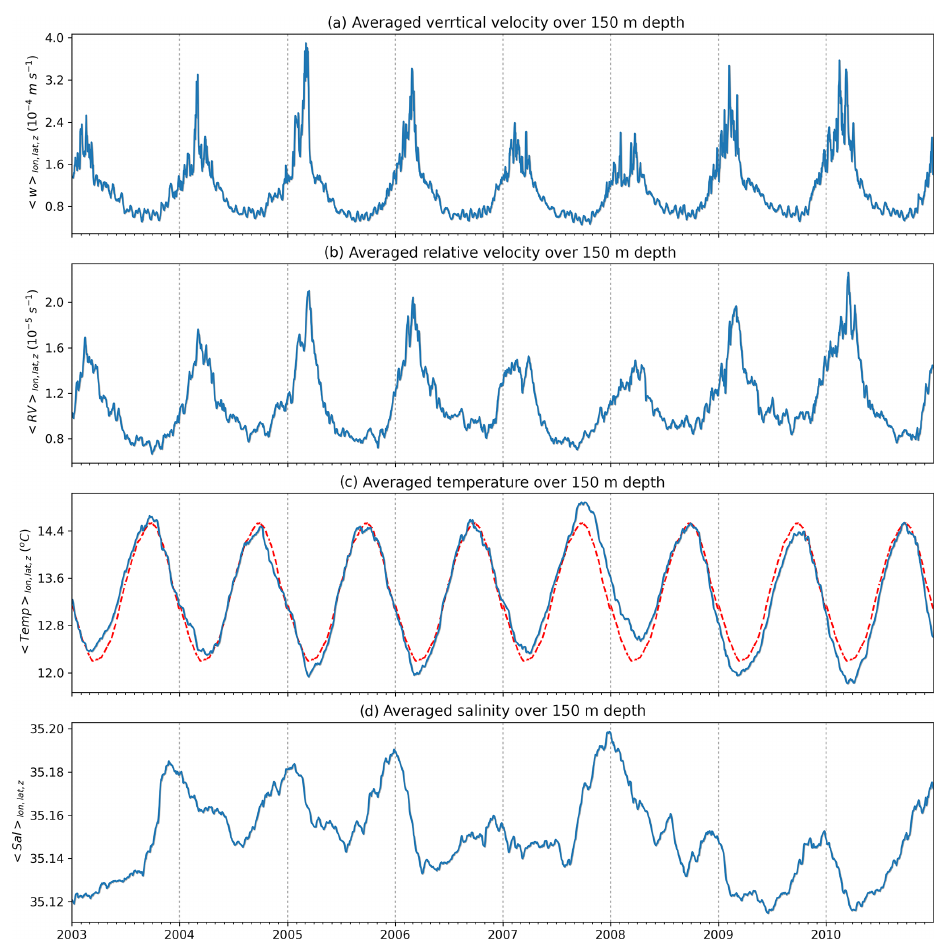
Figure 14. Interannual variability (from 2003 to 2010) of spatially averaged vertical velocity (a) , relative vorticity (b) , temperature (the red dashed line is the average annual cycle during the modelled period) (c) and salinity (d) integrated over 150m depth. The considered domain is given in Fig.